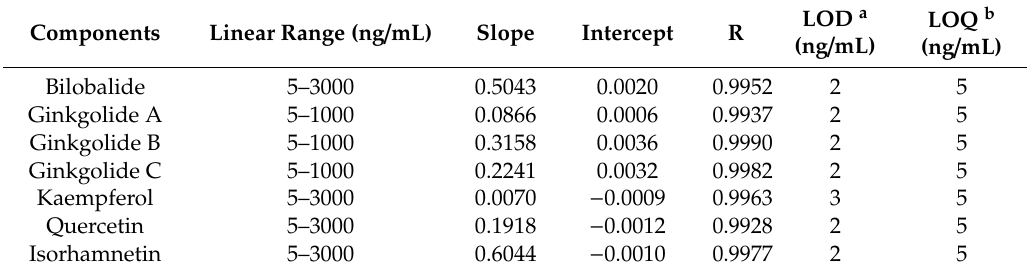
Figure 2. Representative extracted ion chromatograms of ( A ) blank and ( B ) spiked mouse plasma at 5 ng/mL . Table 1. Calibration equations, linear ranges, LODs, and LOQs for the components in ginkgo leaf extracts.